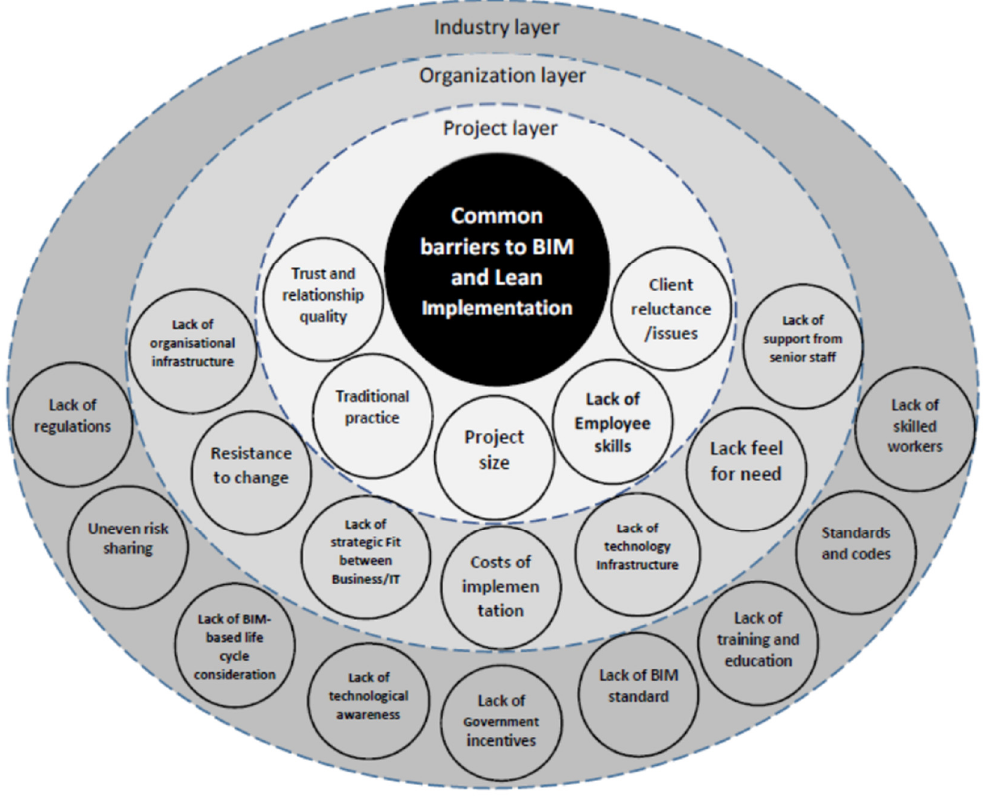
Figure 2. Common Barriers to BIM and lean construction solutions According to [62].